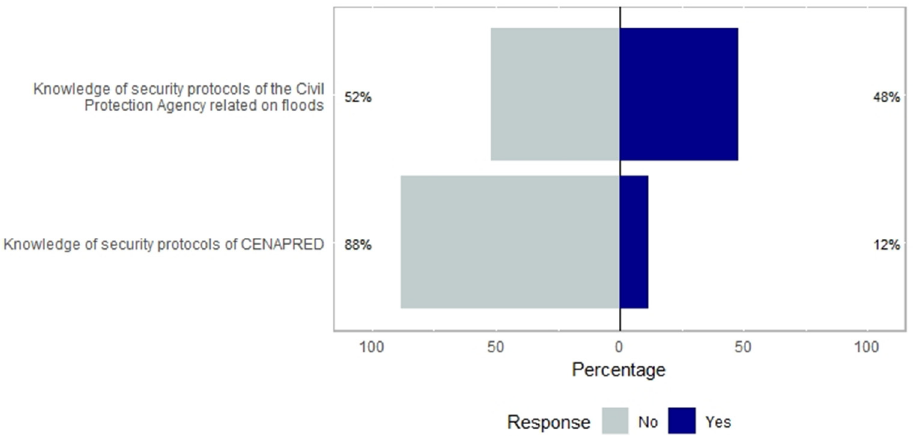
Figure 3. Centered bar plot generated with Likert with response distributions grouped by perceived knowledge of security protocols of the Civil Protection Agency related on floods and knowledge .